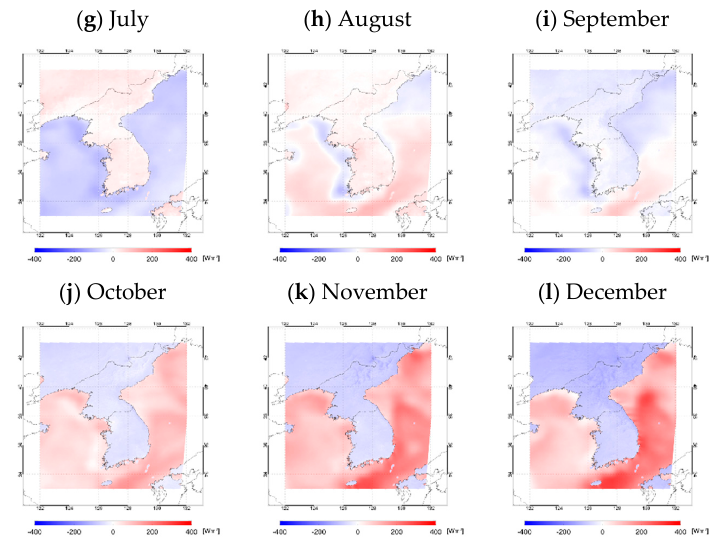
Figure 14. Distribution of monthly mean energy budget ( R A ) in the atmosphere for the Korean Peninsula region in 2016.